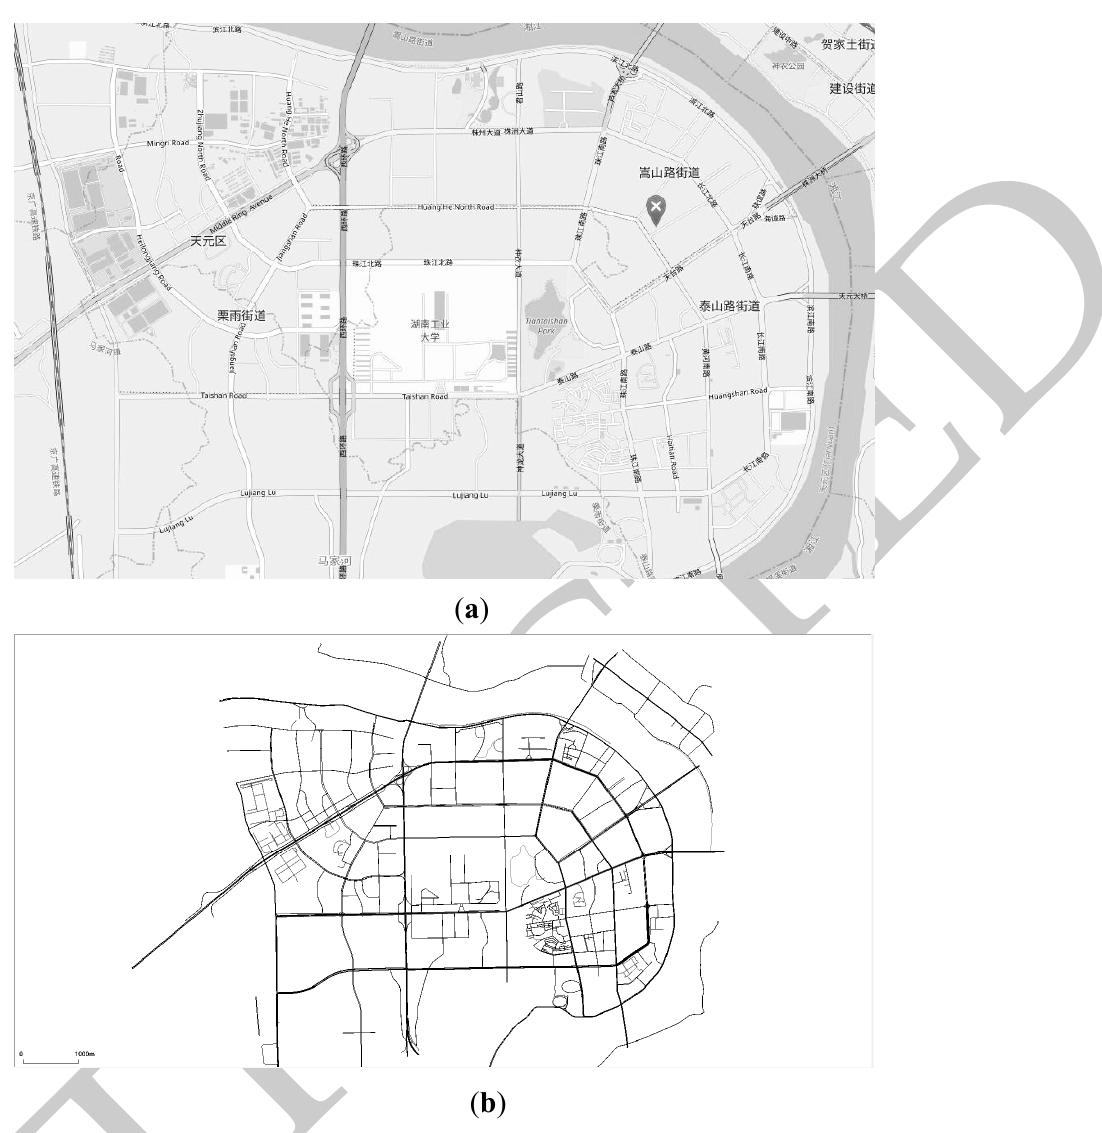
Figure 6. Schematic diagram of the road traffic model: ( a ) map of Tianyuan District, Zhuzhou City, Hunan Province; ( b ) schematic diagram of road files generated by SUMO. Table 2. Simulation